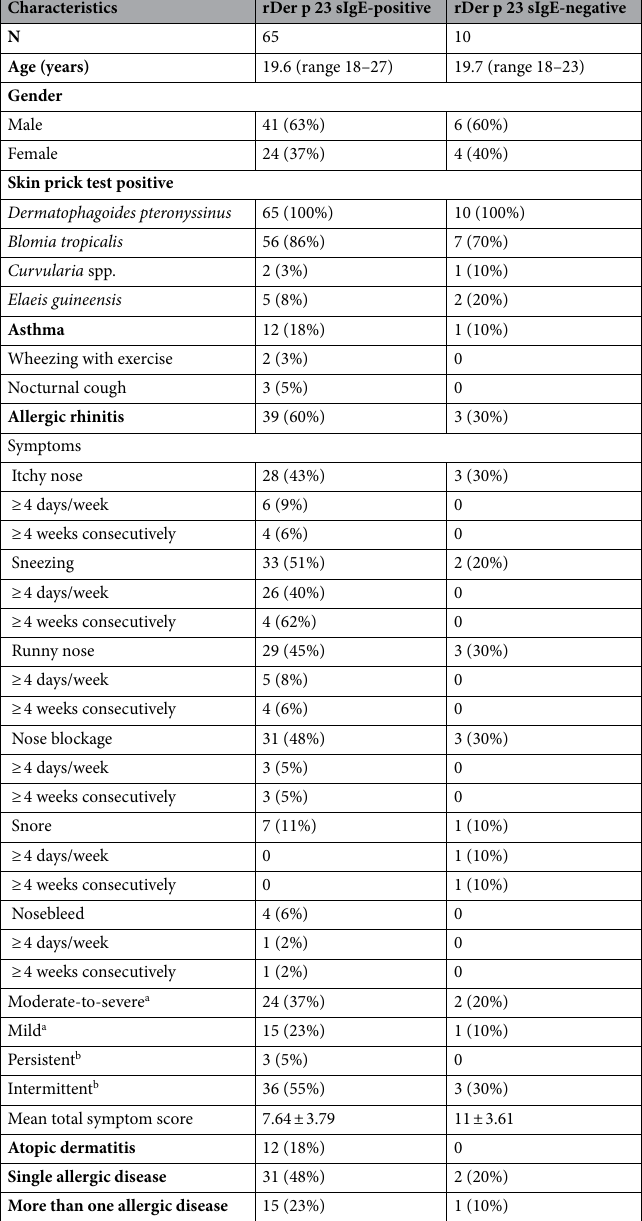
Table 1. Characteristics of participants included in the study. The differences between rDer p 23-positive and rDer p 23-negative groups were not statistically significant. a Severity of allergic rhinitis: moderate-to-severe (disturbed sleep and/or impaired daily activities, sport, leisure, and/or impaired work and school and/or troublesome symptoms); mild (normal sleep, no impairment of daily activities, sports, leisure, no impairment of work and school and no troublesome symptoms). b Persistence of allergic rhinitis: persistent (≥ 4 days per week and ≥ 4 weeks for any of the symptom of itchy nose, sneezing, runny nose, and nose blockage); intermittent (< 4 days per week or < 4 weeks for any of the symptom of itchy nose, sneezing, runny nose, and nose blockage). P values were calculated using chi-square test or Fisher’s exact tests (for sample size <